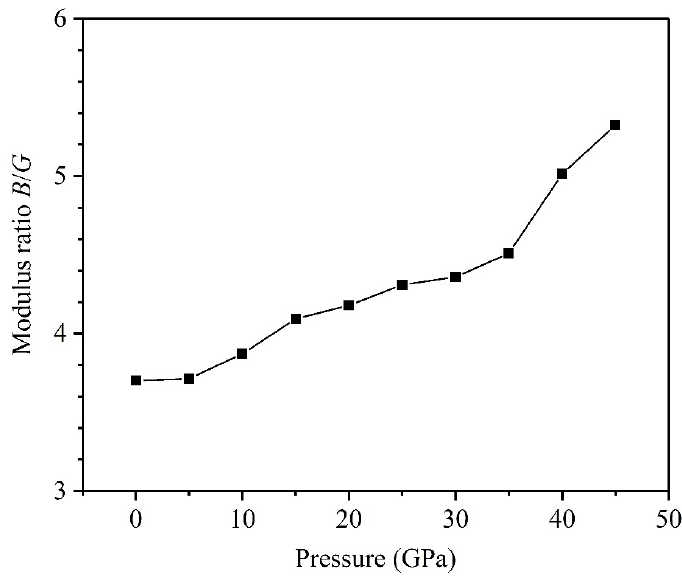
Figure 6. Variation curve of modulus ratio / B G under different pressures for the NiTi SMA.